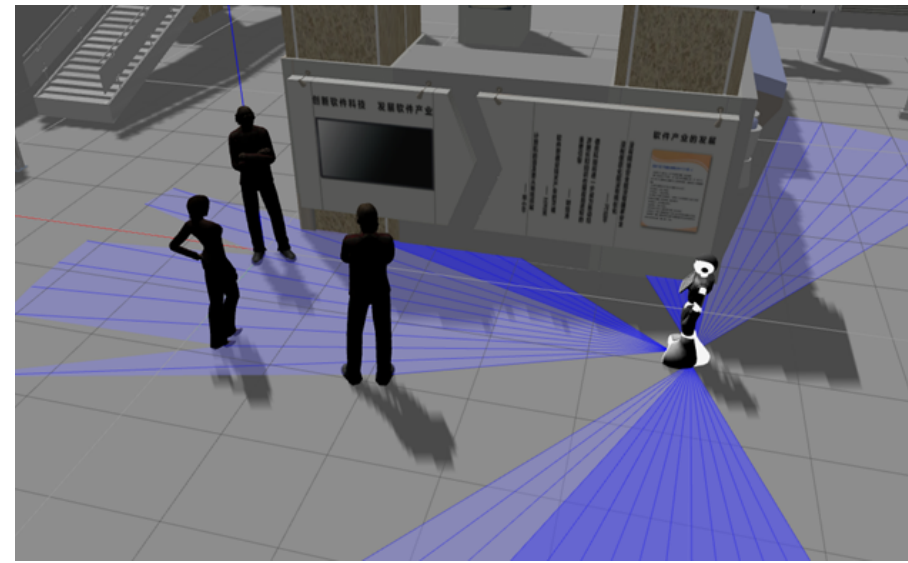
Figure 10. Robot in front to a group of humans.